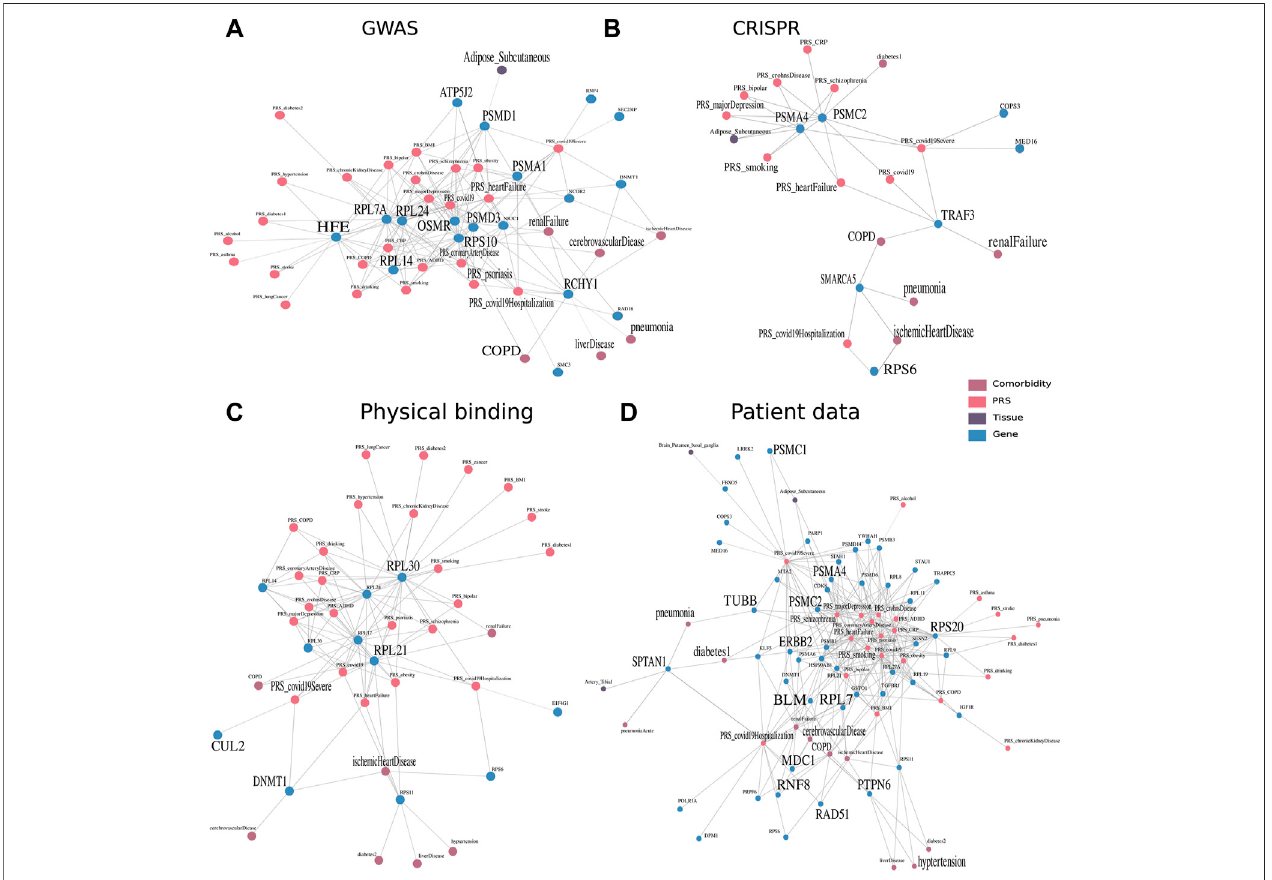
FIGURE 4 | Multimodal context of known host factors important for COVID-19, stemming from different public experimental and patient data sources. Multimodal context, especially with regard to the tissues, PRS, and COVID-19 comorbidities, was represented as a network, an edge between two nodes was drawn when the similarity score within the embedding space > 0.65 and robustly identi fi ed in 80 of 100 run repetitions. Similarity networks of genes derived through (A) GWAS studies (The COVID-19 Host Genetics Initiative 2020) and (B) CRISPR studies derived from Wei et al. (2021) and Schneider et al. (2021). (C) Furthermore, physical interactionexperimentsofribonucleoproteincapturesandimmunoprecipitation(Gordonetal.,2020;Leeetal.,2020),aswellas (D) patientdataofwholebloodsamples (Shen et al., 2020; D ’ Alessandro et al., 2020; Di et al., 2020; Messner et al., 2020; Wu et al., 2021; Overmyer et al., 2021; Geyer et al., 2021; Demichev